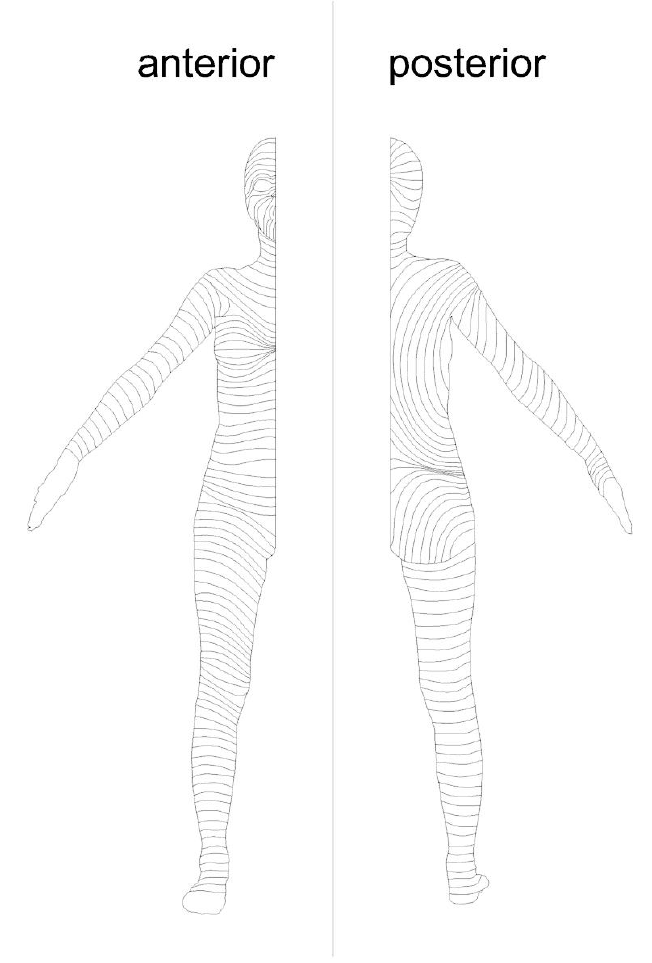
Figure 1. Relaxed skin tension lines.